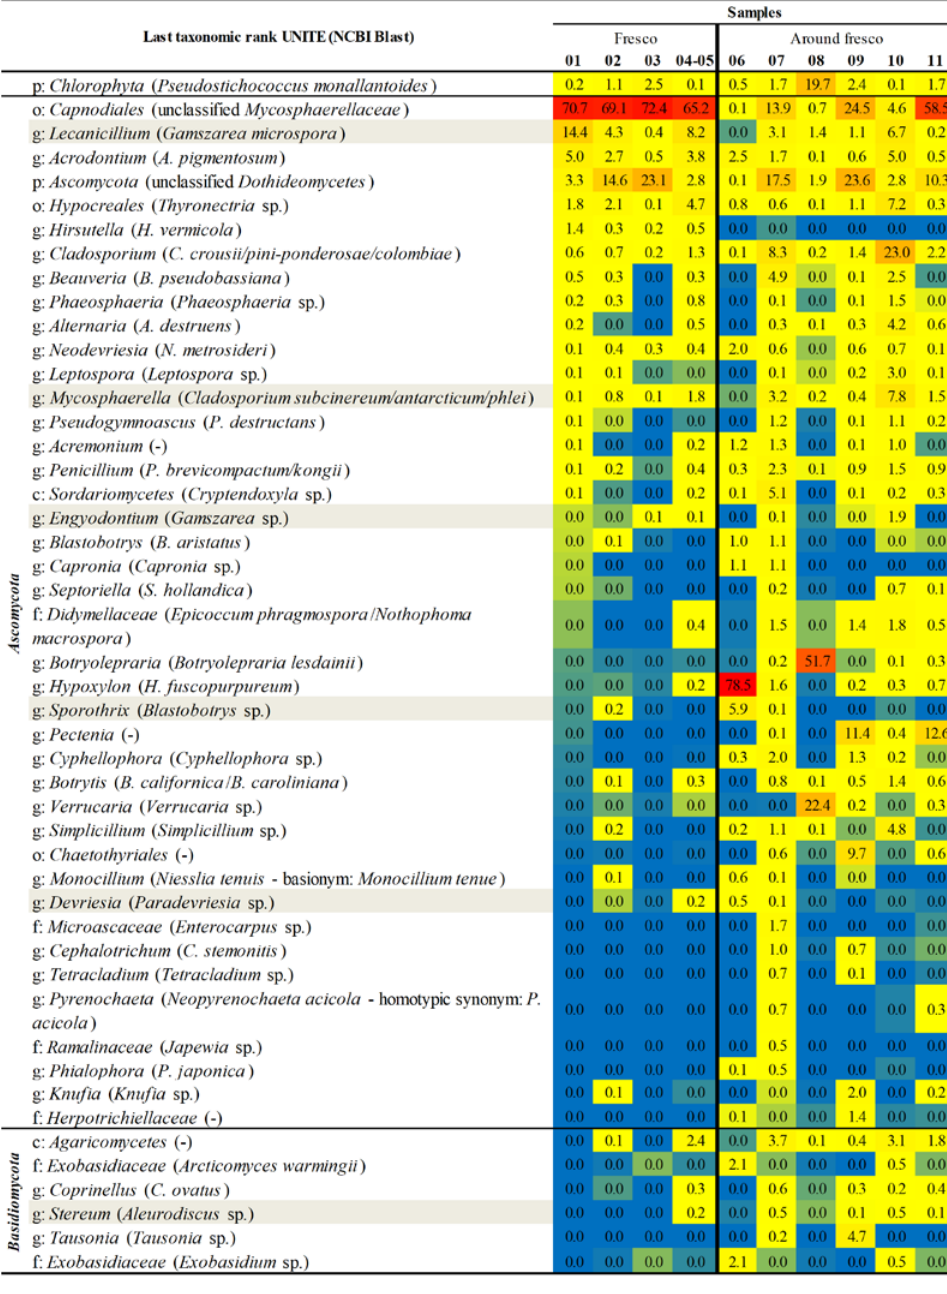
Figure 10. Relative abundance of fungal taxa at the last taxonomic rank according to UNITE database and NCBI assignments at the species level. Relative abundances of fungal taxa are present at all proportion levels, and different colors indicate low or high abundance. (p)—phylum; (c)—class; (o)—order; (f)—family; (g)—genus; (-)—not determined. The gray color indicates differences between UNITE and NCBI results. Only taxa with a total percentage abundance above 0.5% for all samples were included. Blue, yellow, and red colors—lowest, medium, and highest RA.